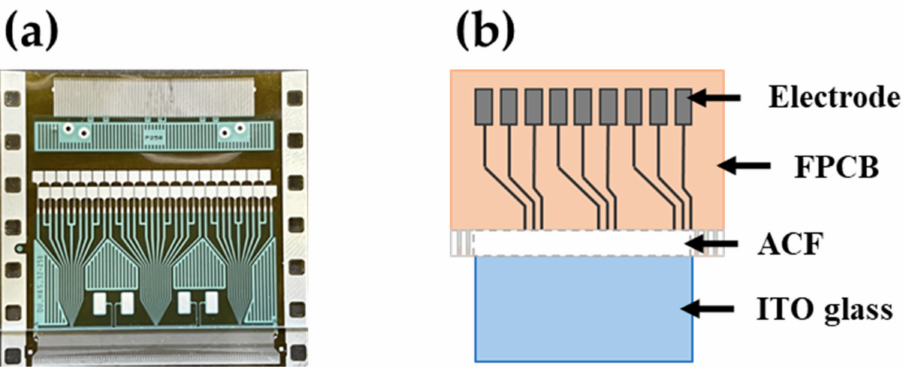
Figure 15. FPCB and schematic diagram for measuring the contact resistance of the manufactured conductive ball: ( a ) real sample of PFCB substrate with 20 µ m pitch and ( b ) schematic diagram for composing flex-on-glass